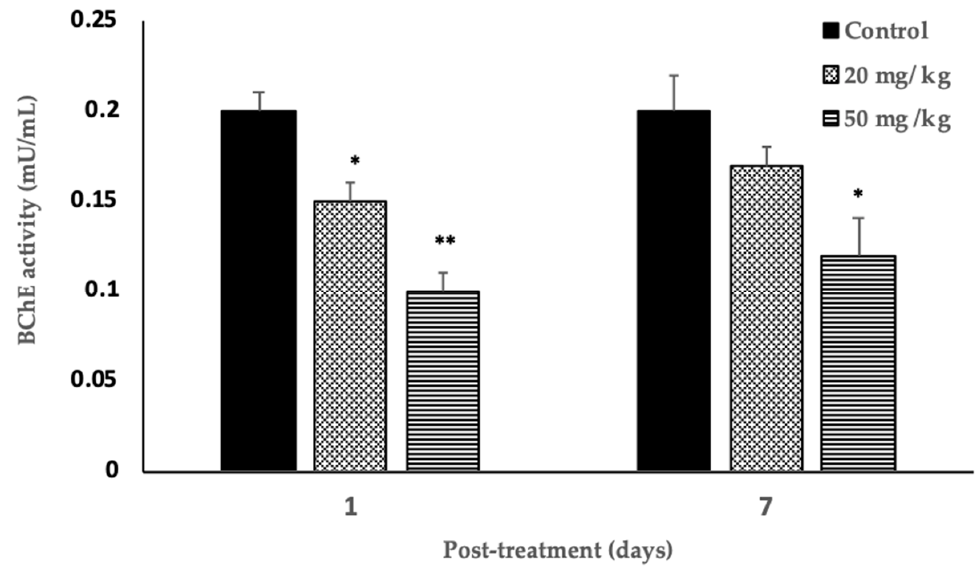
Figure 2. Effects of Judo 40 on BChE (blood acetylcholinesterase) activity of rats on posttreatment days one and seven. The bars represent rats ( n = 9) treated either with Judo 40 (50 and 20 mg / kg) or the control (corn oil) on post treatment days one and seven. Results are expressed as mean ± SEM, * p < 0.05, ** p < 0.01.